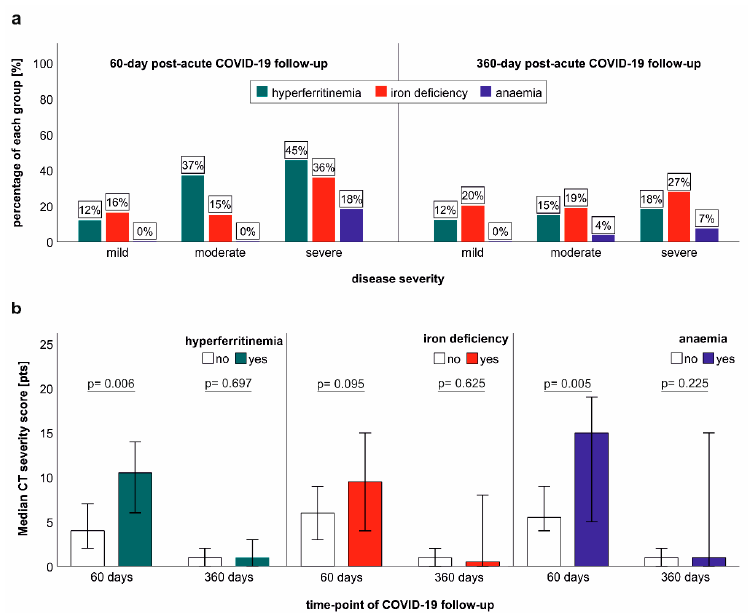
Figure 4. Association of acute COVID-19 severity with iron dyshomeostasis and anaemia at early and long-term COVID-19 follow-up. ( a ) Frequency of hyperferritinaemia, iron deficiency and anae- mia at 60 days and 360 days post-COVID-19 follow-up. ( b ) Structural lung abnormalities were as- sessed with computed tomography (CT) in patients with hyperferritinaemia, iron deficiency and anaemia at early and long-term post-COVID-19 follow-up. Error bars indicate 95% confidence in- tervals; p -values are depicted according to the Mann-Whitney-U test. 2.7. Impact of Iron Dyshomeostasis and Anaemia on Long-Term Symptom Burden and Exercise Tolerance Iron dyshomeostasis and anaemia are not only relevant findings during acute COVID-19 but may also be of importance for post-COVID-19 recovery [20]. Thus, we in- vestigated the association of iron dysbalance and anaemia with patients’ resilience coping, fatigue, quality of life (QoL) and exercise capacity at long-term follow-up. One year after COVID-19 onset, a relevant sub-cohort of patients demonstrated chronic impairments as far as persistence of fatigue, impairment of the QoL and exercise capacity are concerned. In detail, the mean European Quality of Life visual analogue scale (EQ-VAS), which pro- vides patients’ QoL self-reports, was 85% (CI 79.7–85.0%), whereas 100% would describe a perfect QoL. The Chalder Fatigue Scale (CFS) assessment, which reflects the severity of tiredness in patients with fatigue, resulted in a median Likert score of 12 points (CI 12.4– 15.0 points), whereas 37% exceeded a score of 14—indicating increased fatigue— and two patients demonstrated a CFS score equal or above 28, which is indicative for chronic fa- tigue syndrome. Accordingly, 8.8% (N = 9) of patients displayed a reduced six-minute walking distance. Notably, resilience was impaired in a substantial portion of the CovILD cohort, as only 45% had high resilience, whereas 26% and 29% demonstrated medium and low resilience, respectively. Interestingly, whereas fatigue, QoL and exercise capacity were not significantly related to iron dyshomeostasis or anaemia, a reduction in resilience was associated with persisting hyperferritinaemia, iron deficiency and anaemia at long- term follow-up (Figure 5).